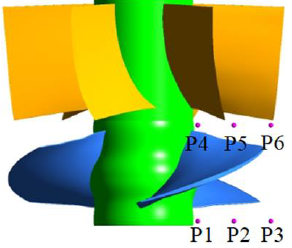
Figure 15. Arrangement of pressure monitoring points.